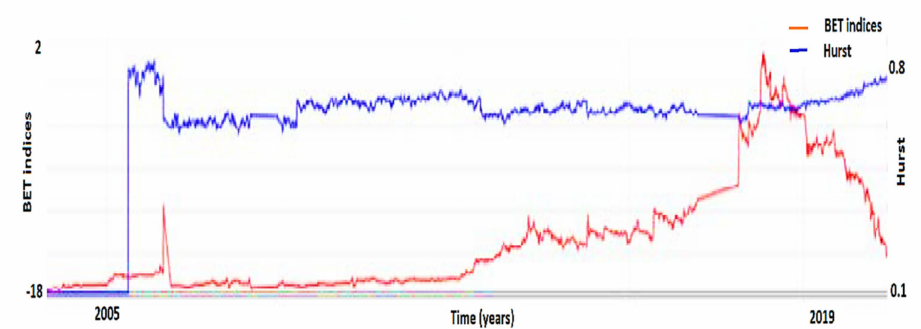
Figure 7. Evolution of the Hurst exponent according to the BET index.